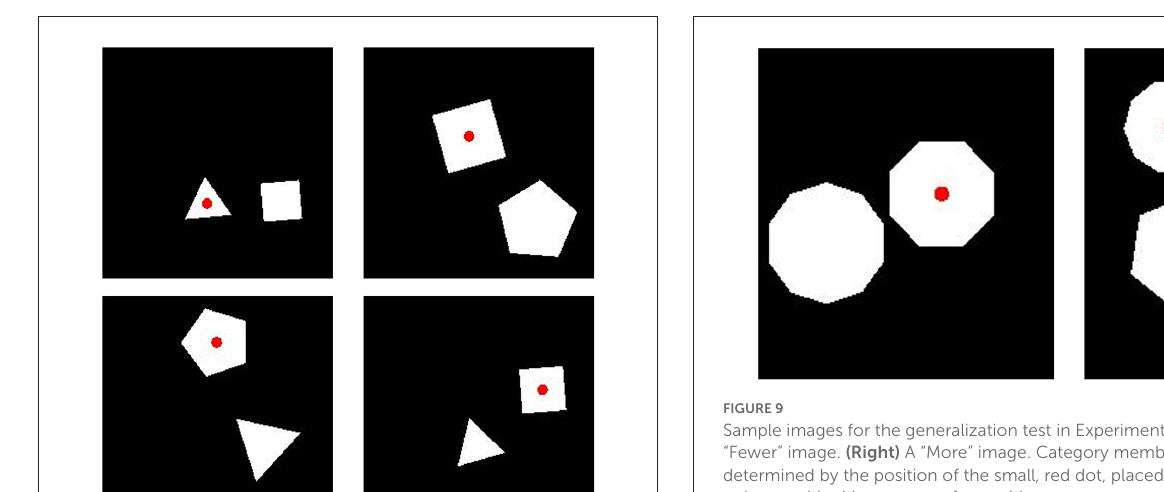
on the polygon with fewer sides. Sample test images are shown in Figure